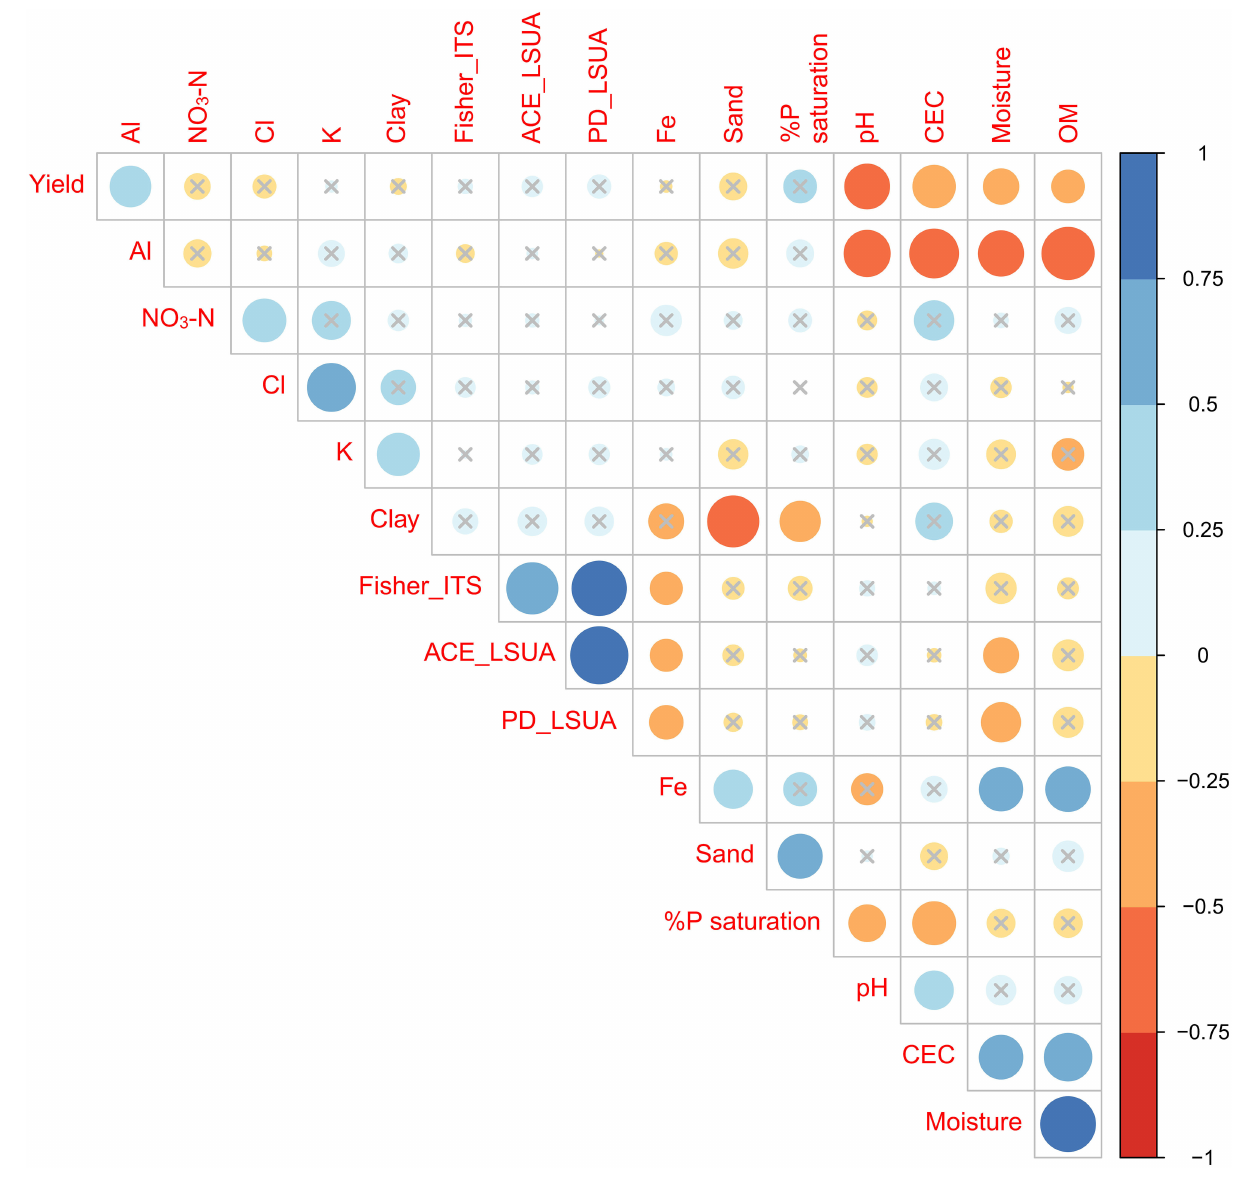
FIGURE 10 | Clustered correlation matrix of key soil factors, significant diversity indices, and yield. Non-significant ( p > 0.05) correlation coefficients are marked by gray ×